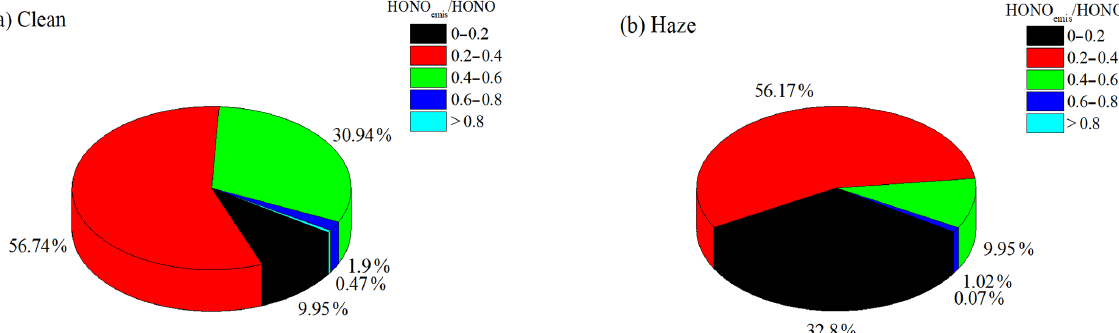
Figure 7. The nocturnal HONO emis / HONO ratios frequency distribution during (a) clean and (b) haze episodes.